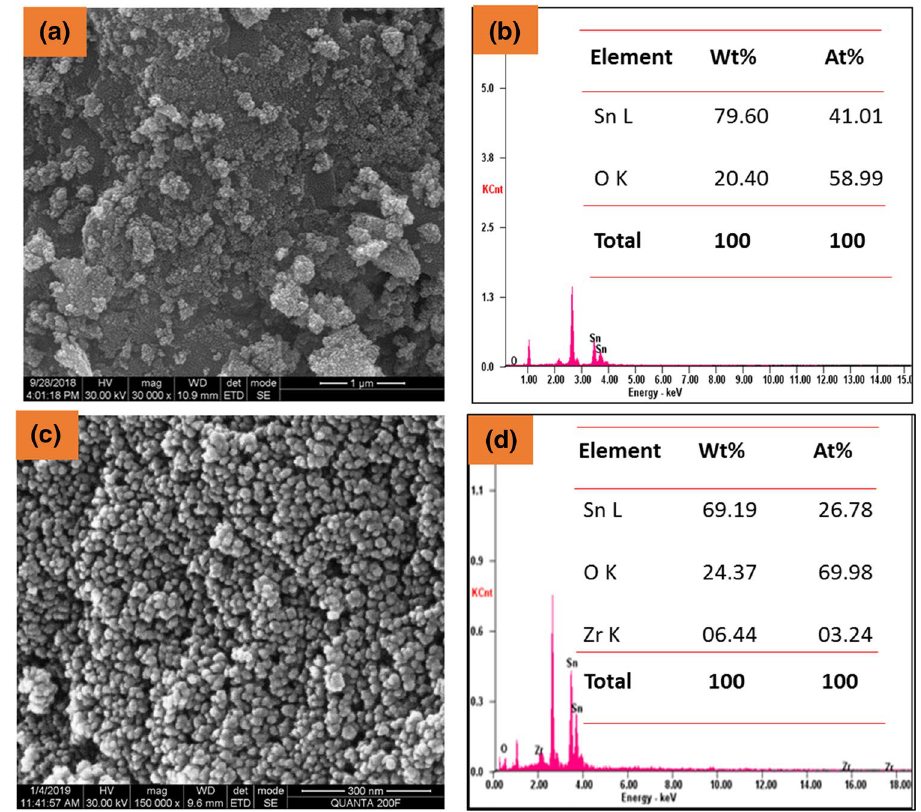
Fig. 3 a , c FESEM images